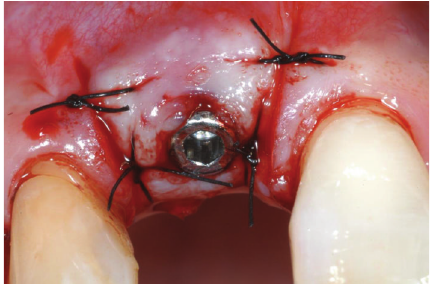
Figure15:Immediatelyafterimplantplacement,ahealingabutment was connected to the implant. The mucosal flap was adjusted to the healing abutment and then sutured in